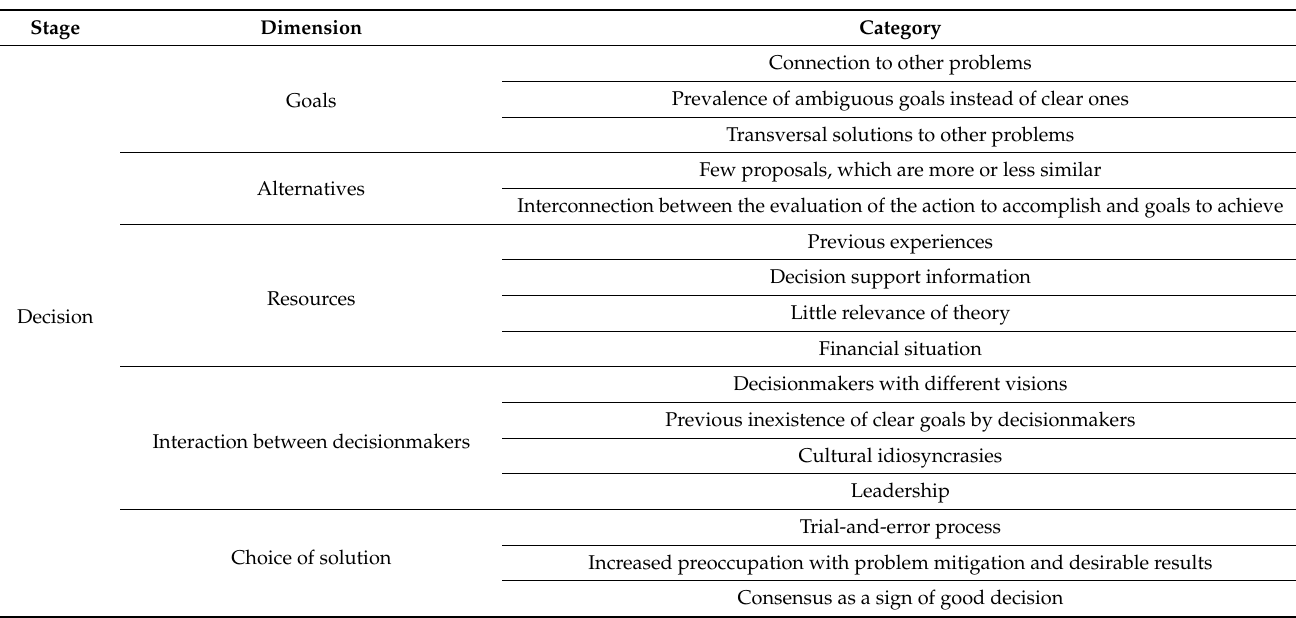
Table 2. Dimensions and categories of the decision-making